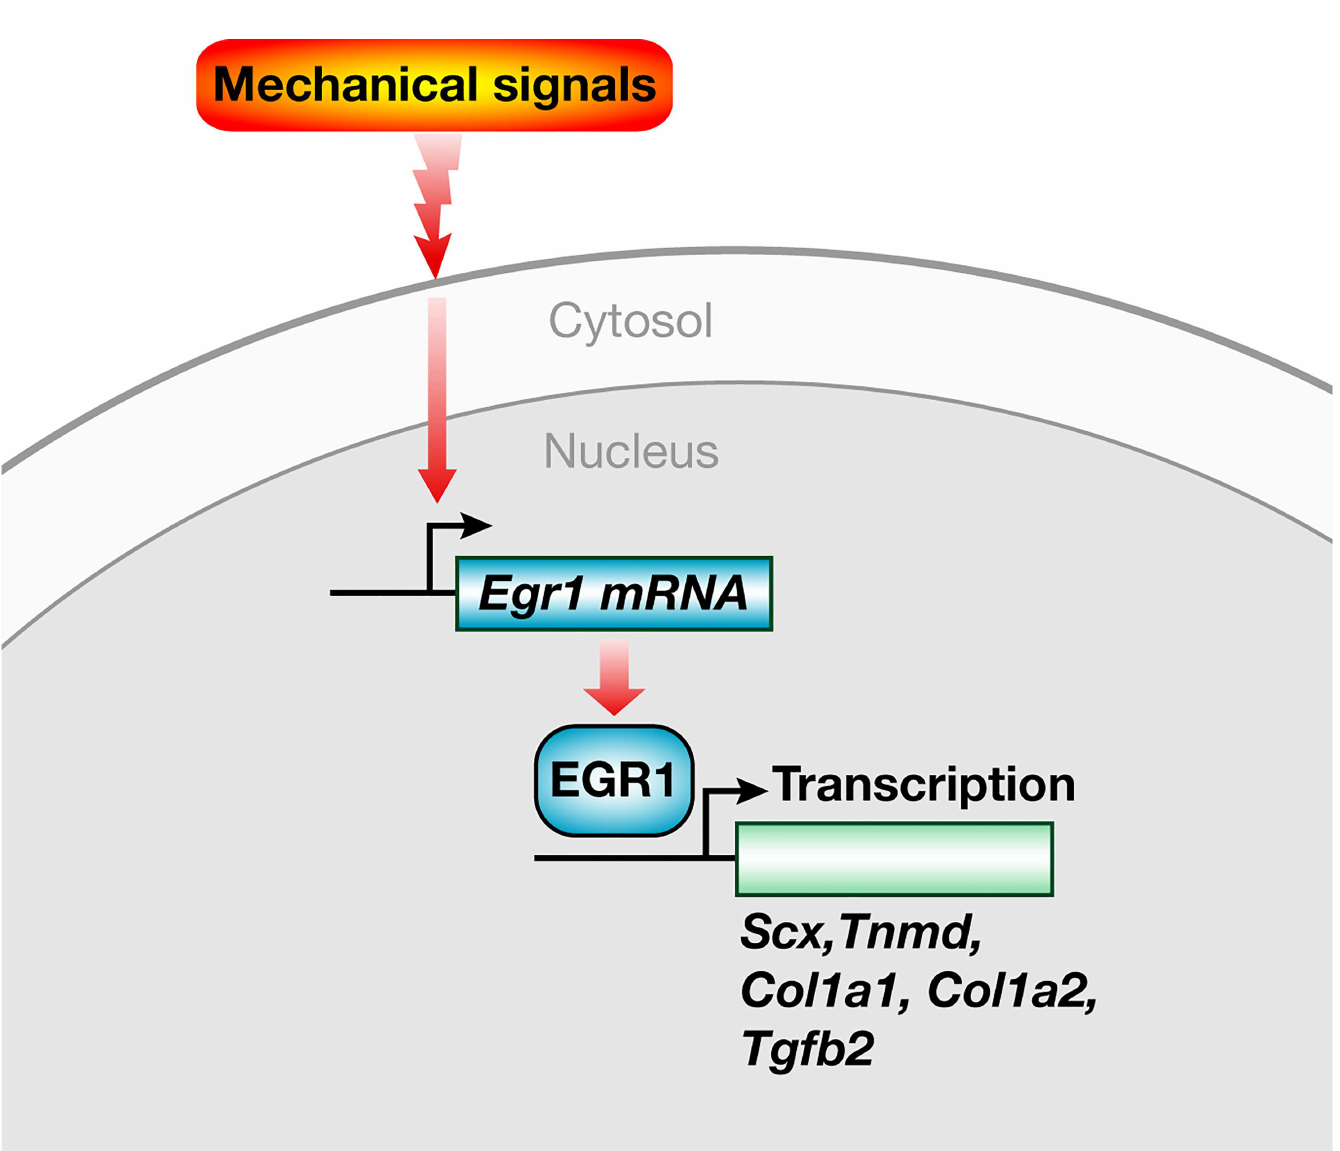
Fig 5. Schematic representation of EGR1 regulation and function downstream of mechanical signals. Egr1 expression is regulatedby mechanical signals in tendon cells. EGR1 positively regulates the transcription of tendon genes including Scx , Tnmd , Col1a1 and Co1a2 . The transcription of Tgfb2 is also regulated by